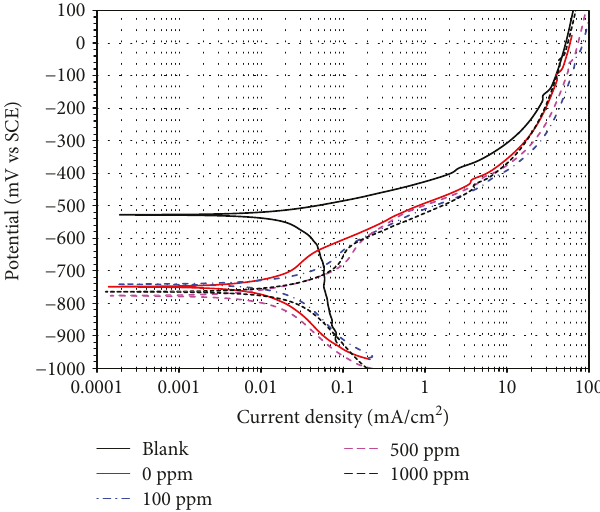
Ti O 2 2 7 Figure 8: Polarization curves for 1018 carbon steel bare and coated with chitosan doped with